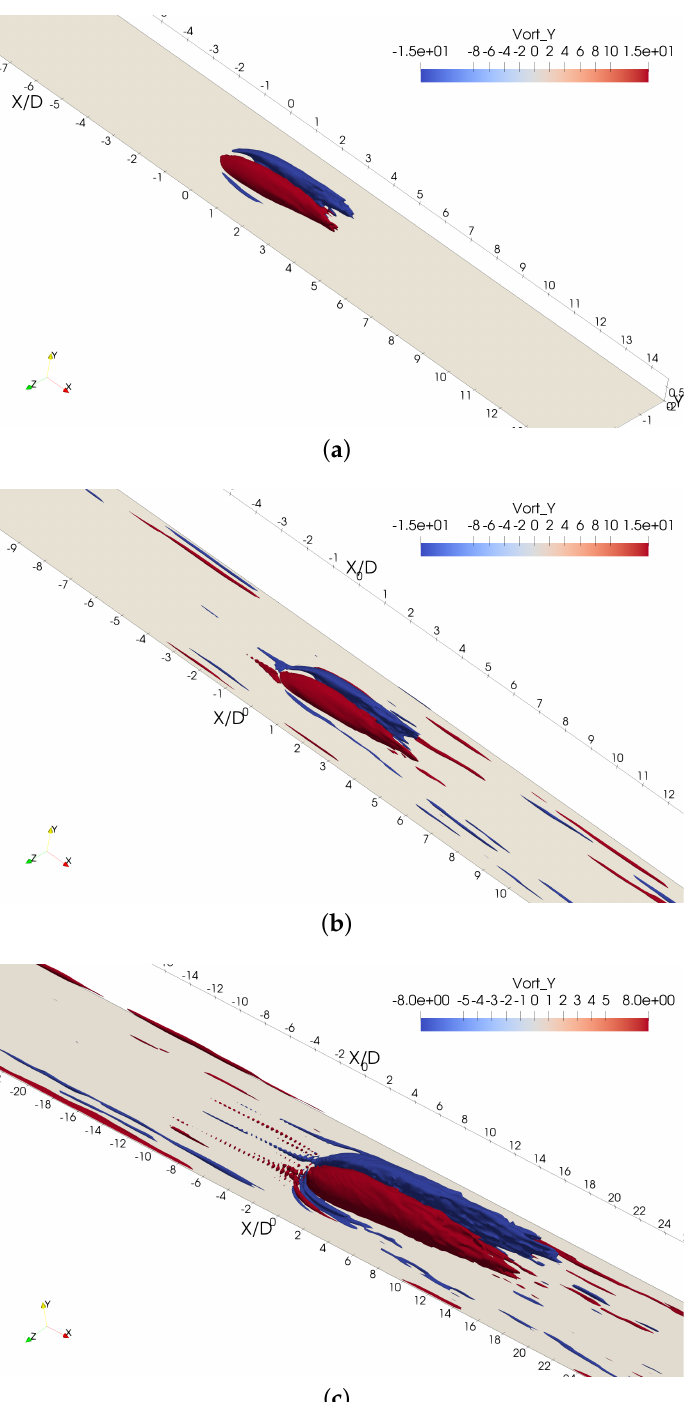
Figure 19. Iso-surfaces of time averaged wall-normal vorticity Ω y (1/s). ( a ) VR = 0.5 ZPG. ( b ) VR = 0.5 FPG. ( c ) VR = 1